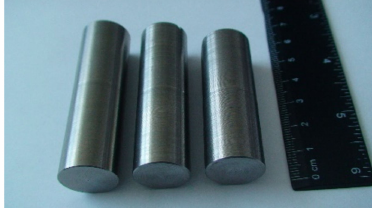
Figure 1. Photograph of the ingots